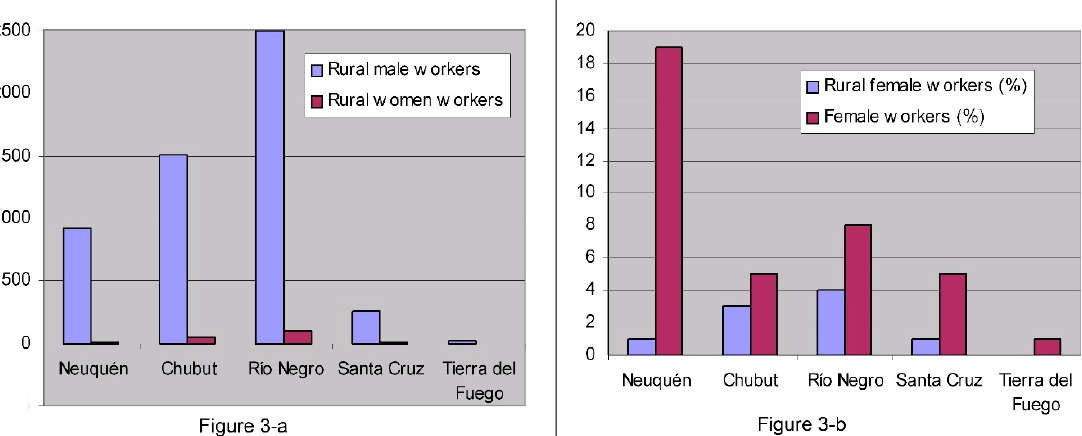
Figure 3. Characterisation of work. Female rural work in Patagonia in 1914. ( a ) Differences between male and female rural workers. ( b ) The percent of rural women workers in the general percent of women workers in each province. Own elaboration on the base of 1914 Census.